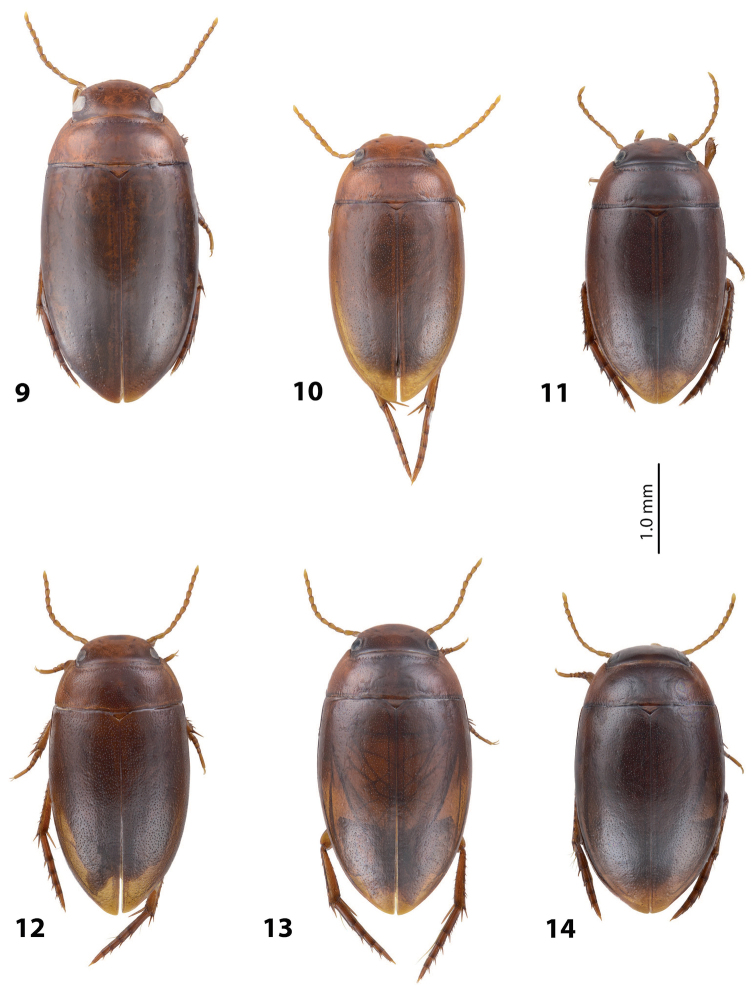
Habitus and coloration 9Exocelinapiusi sp. n. 10E.pusilla sp. n. 11E.sumokedi sp. n. 12E.cyclops sp. n. 13E.bewani sp. n. 14E.adelbertensis sp. n.